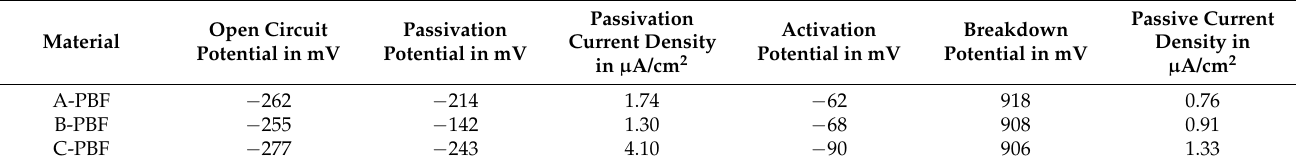
Table 6. Results of current/potential tests performed on the three PBF-LB/M-processed 316L variants in the as-built condition.